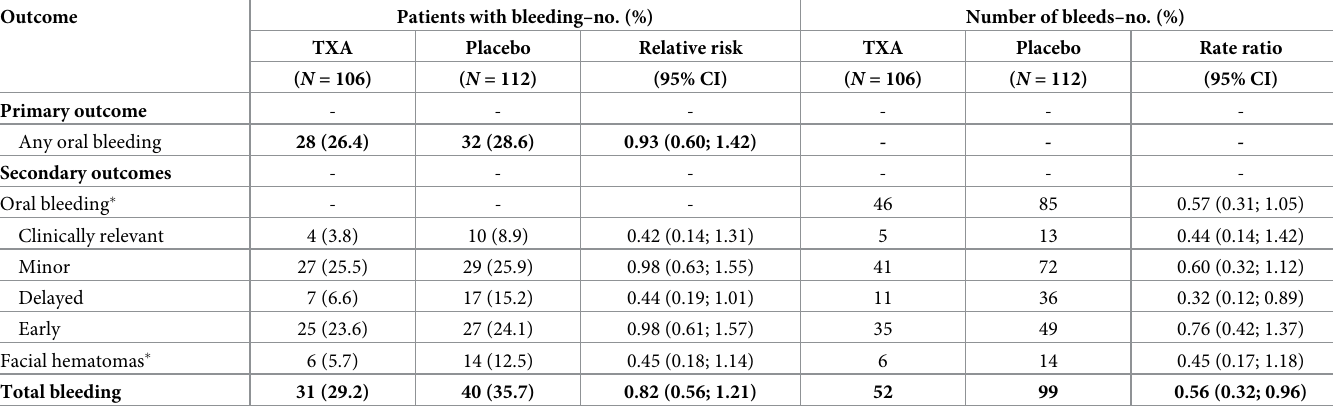
Table 2. Primary and secondary bleeding outcomes.